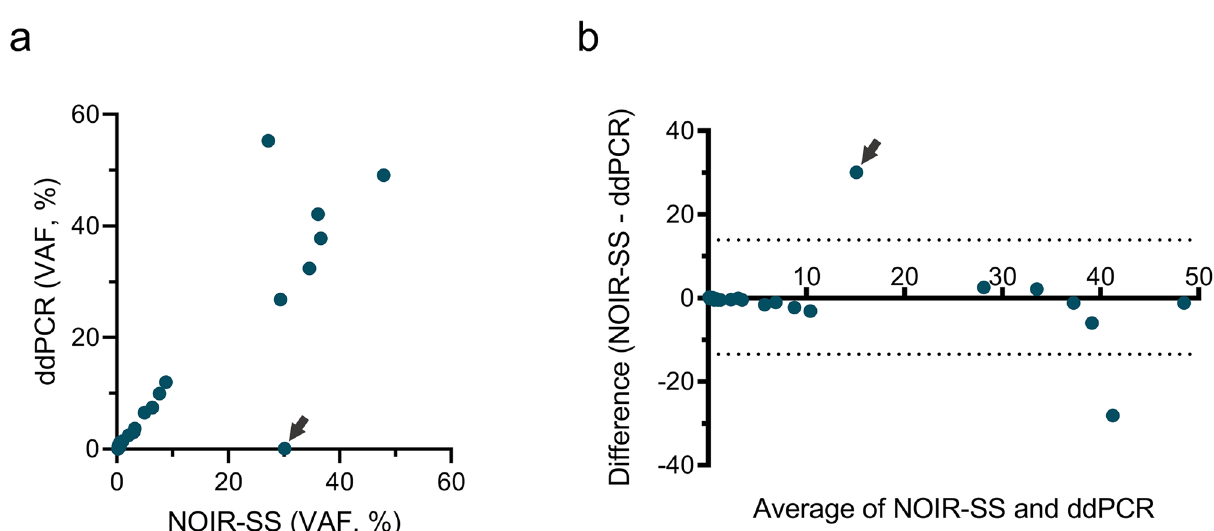
Figure 2. The ctDNA EGFR L858R variant allele fractions (VAFs) assessed by nonoverlapping integrated read sequencing system (NOIR-SS) and droplet digital polymerase chain reaction (ddPCR). ( a ) Scatter plot depicting the correlation of L858R %VAFs determined using NOIR-SS and ddPCR (ρ = 0.90; 95% confidence interval, 0.81–0.95; P < 0.0001). ( b ) Bland–Altman plot of %VAFs determined using NOIR-SS and ddPCR. 95% limits of agreement (dashed lines) are drawn. The arrows indicate the discordant results of the two assays in patient no.